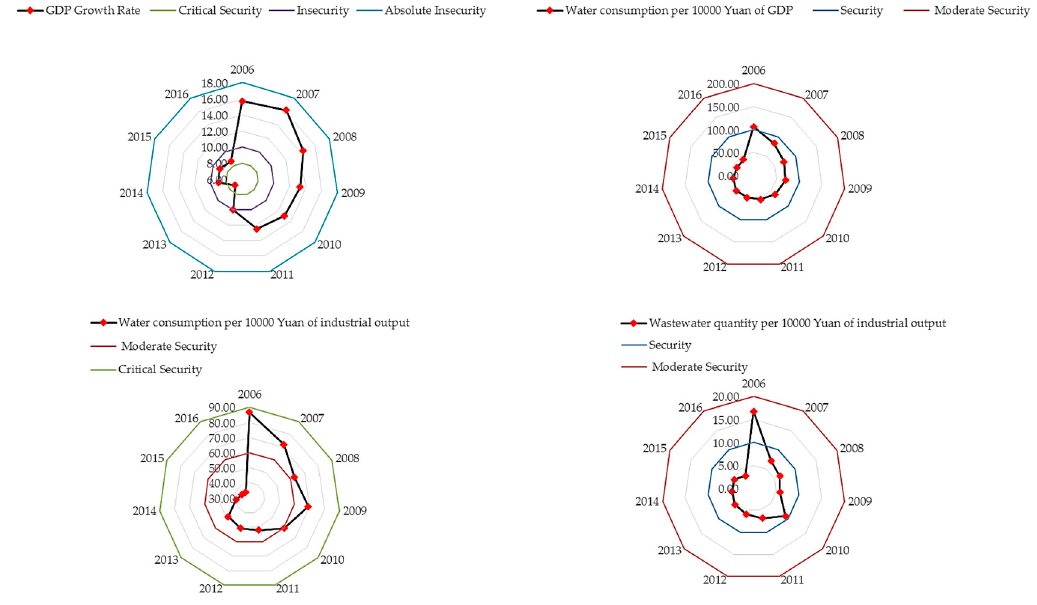
Figure 6. Positive changes of indexes in pressure subsystem from 2006 to 2016.